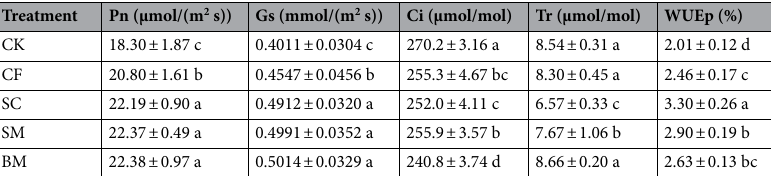
Table 4. Effects of different organic fertilizers on photosynthetic characters of Pear-jujube. Pn-Net photosynthetic rate, Gs-Stomatal Conductance, Ci-Intercellular CO 2 concentration, Tr-transpiration rate, WUEp—water use efficiency. The data are the mean ± standard deviation of the parameters in this group. At different levels, each population mean follows a normal distribution with the same variance. The least significant difference (LSD) method was selected for analysis of variance in DPS software. Different lowercase letters in the same column indicate significant difference between treatments ( P < 0.05).